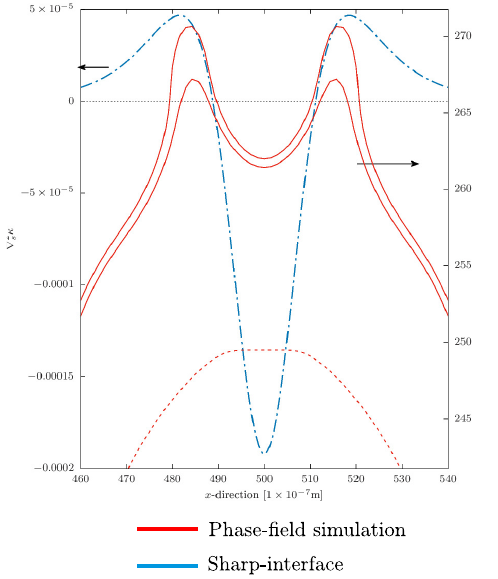
Figure 7. The temporal formation of crests, at x = 490 10 − 7 m, x = 510 10 − 7 m, and the forma- × × tion of a trough at 490 10 − 7 m < x < 510 10 − 7 m exhibit the tip-splitting phenomenon from a × × two-dimensional phase-field simulation (red isolines). The initial interface profile in accordance with Equation (6) is also illustrated. A direct comparison with the analytically obtained positions (blue dashed lines) reveal that both tips are generated in the positive regions of Figure 6, whereas the split region is determined by the negative region of the interface. The left and right arrows respectively 2 indicate the s κ and the grid ∇